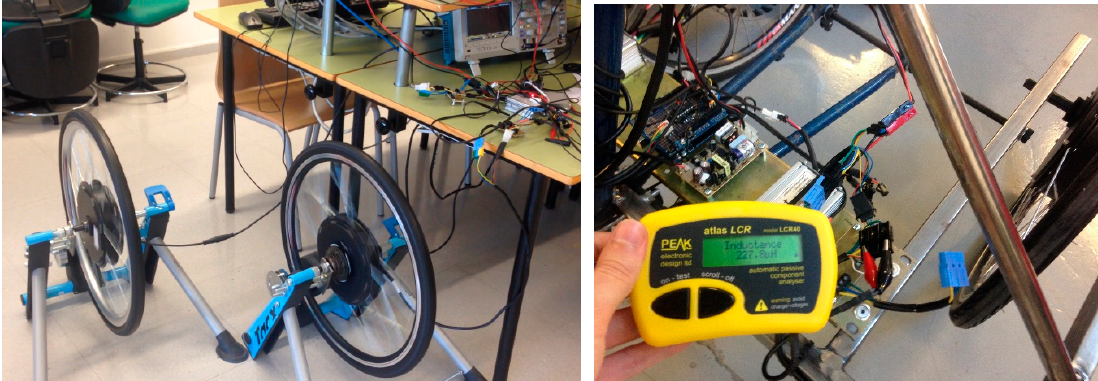
Figure 1. Laboratory development set to characterize the motors used and to configure the electronic differential (ED) control unit according to these selected equipment.